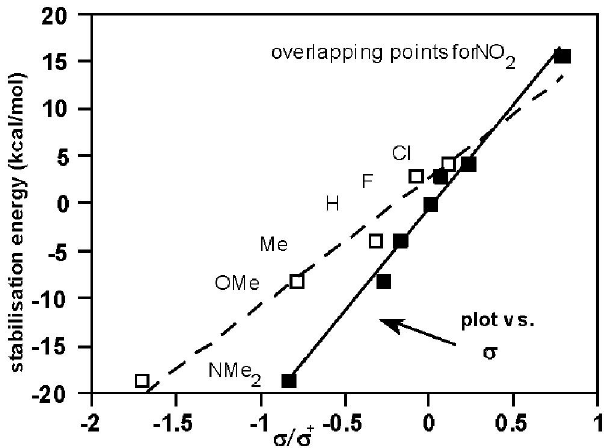
Figure 3. Correlations of HF/6–31G stablisation energies (Equation 2, Table 4) with σ and σ p+ ; slope: 21.7 ± 1.1; intercept: −0.56 ± 0.50; r =